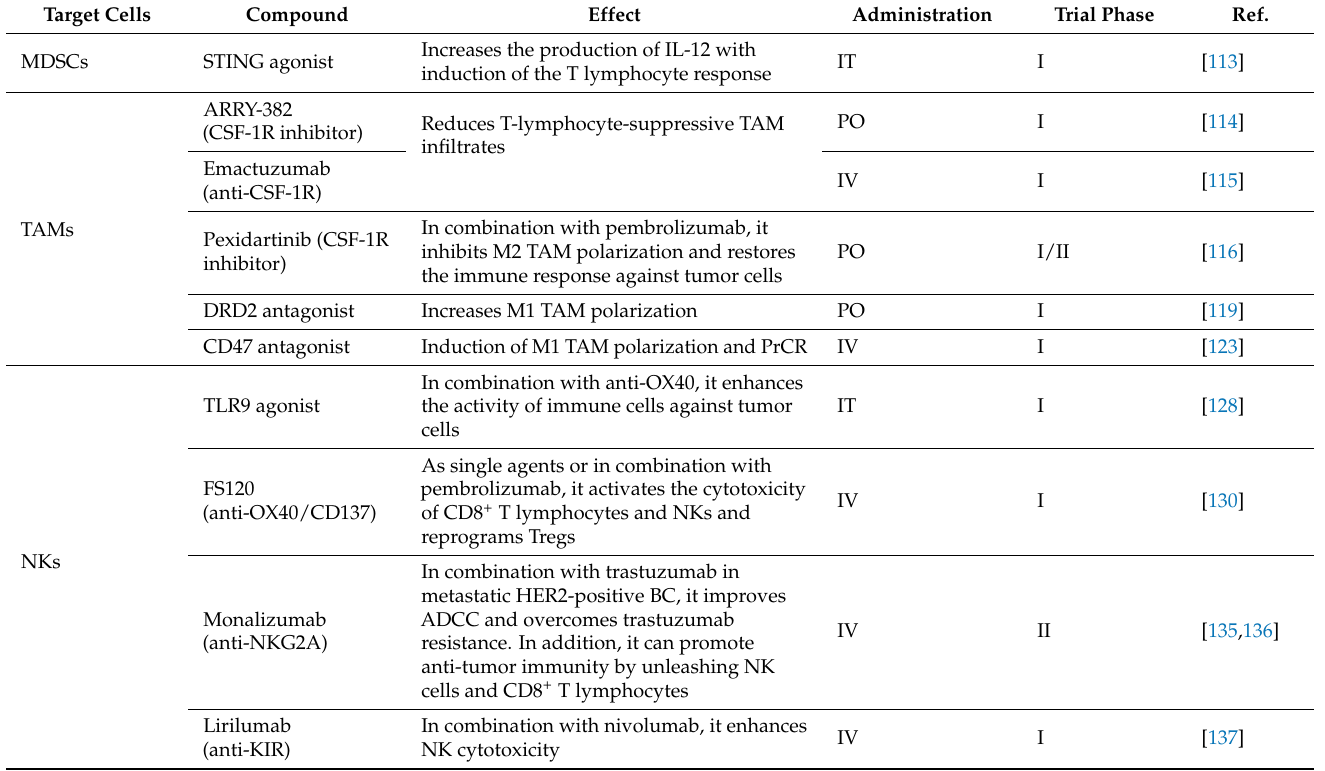
Table 2. Available compounds targeting the innate immunity